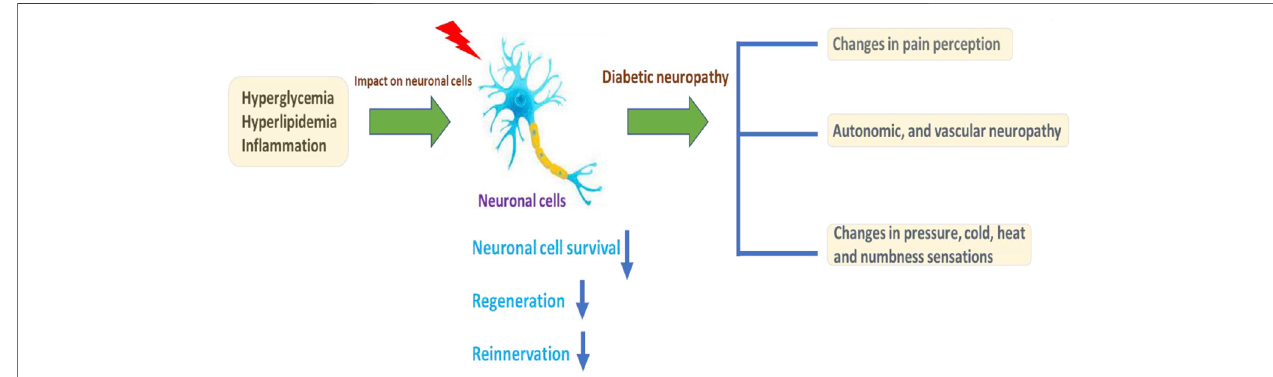
FIGURE 1 | Illustration of DM conditions ’ in fl uence on the neuronal cells and DNP development, with further cellular consequences.